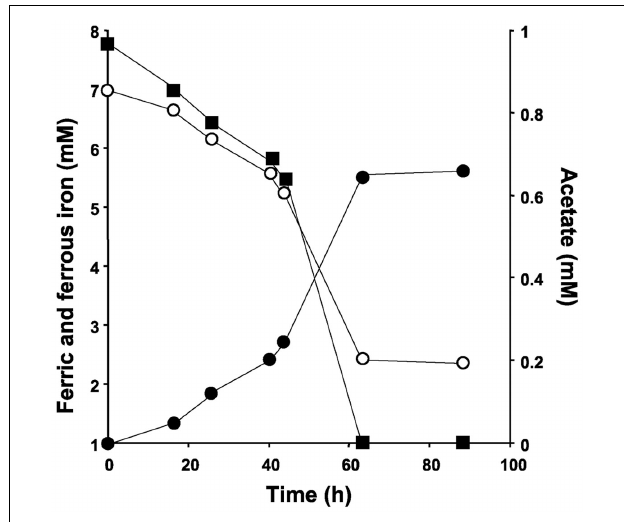
FIGURE 1 |Activity of the pure iron-reducing Geobacter sp. culture. The closed squares indicate acetate, the closed circles ferrous iron, and the open circles ferric